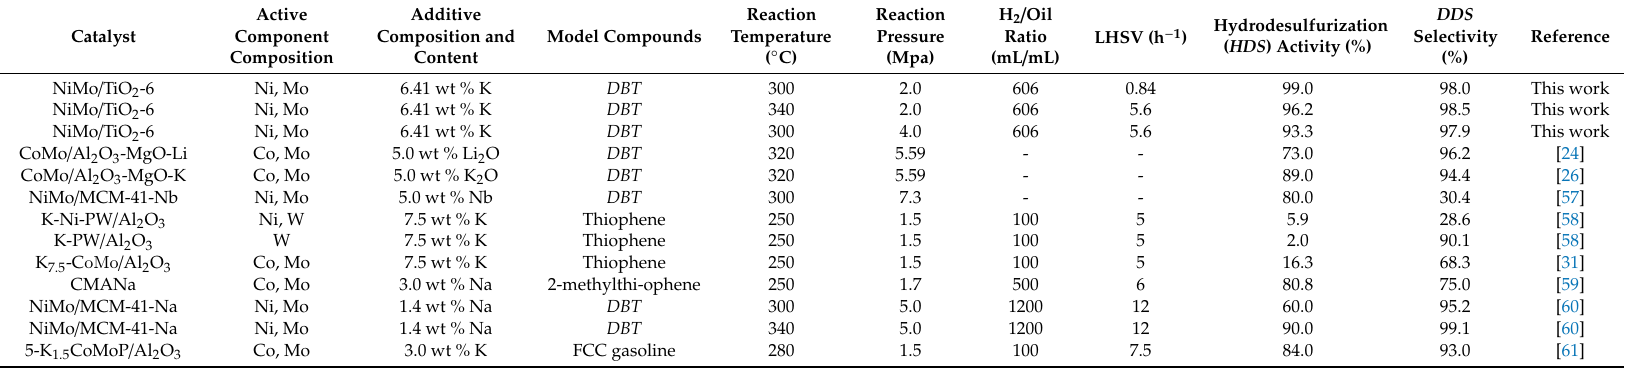
Table 3. Comparison of catalyst performance with literature reports in DBT